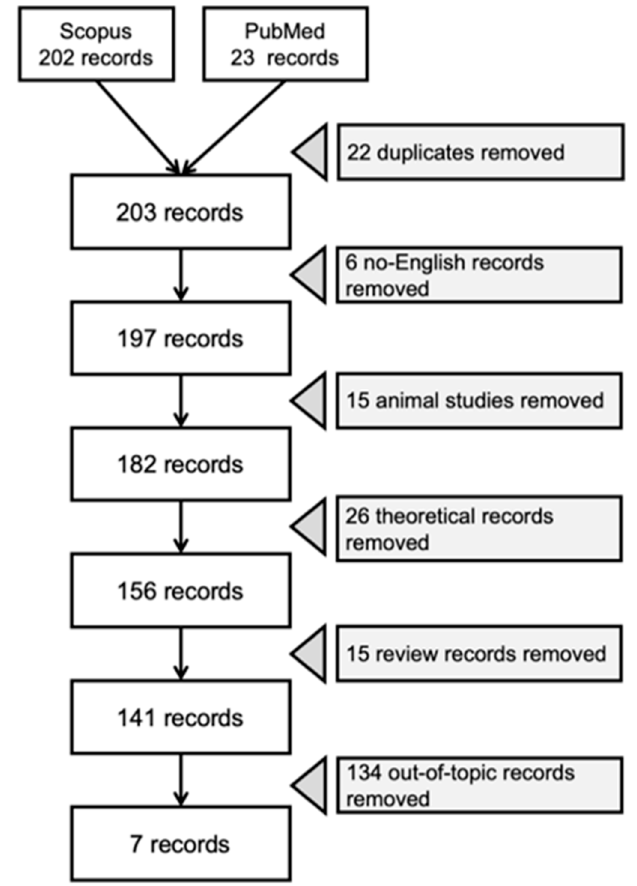
Figure 1. Study selection flowchart.